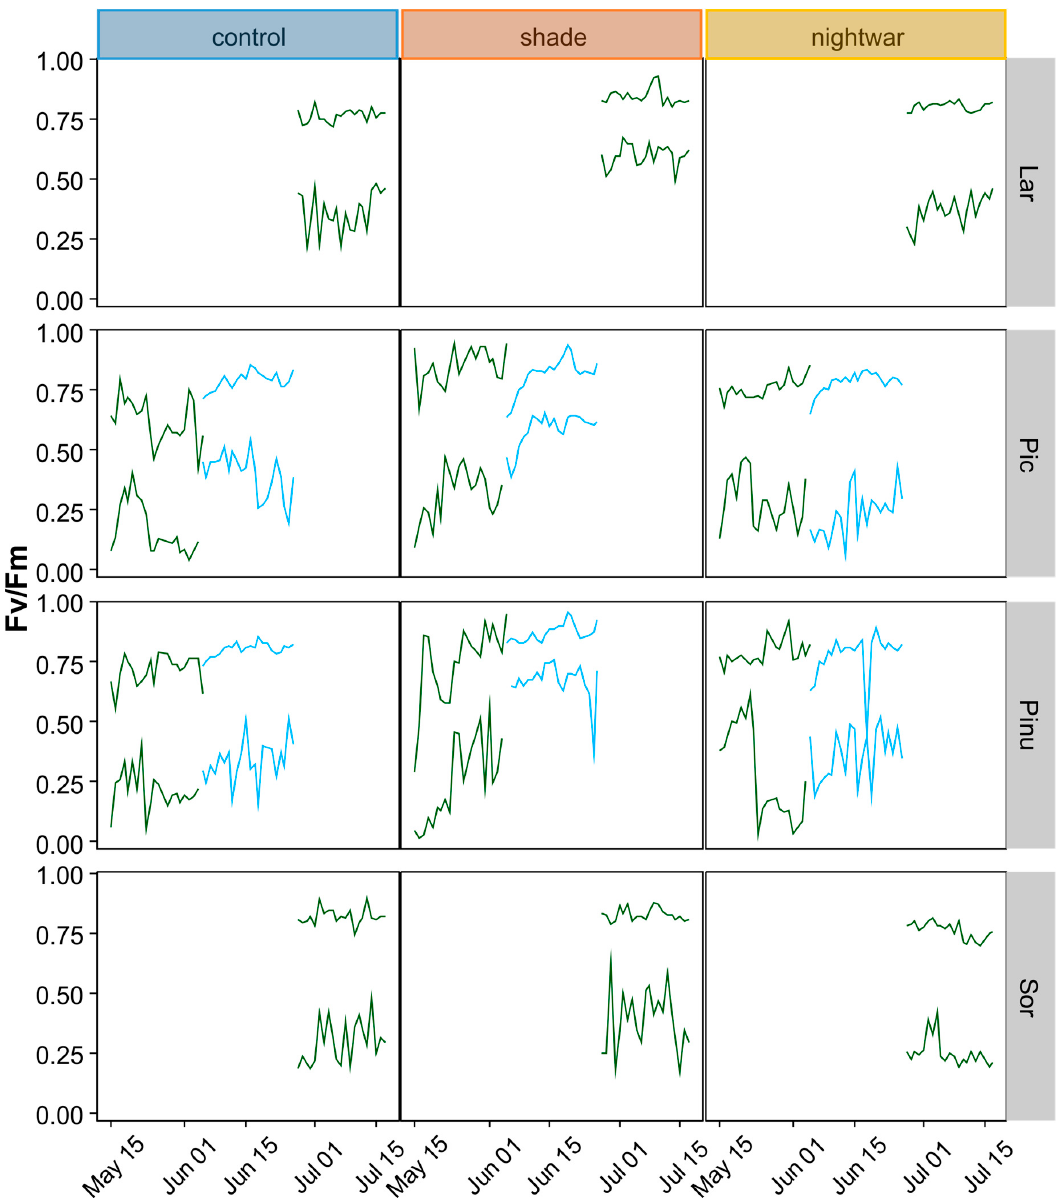
Figure A3. Time-courses of the quantum yield (chlorophyll fluorescence parameter Fv/Fm, or Δ F/Fm´ during daylight hours) in seedlings of four tree species grown in different experimental treatments near the treeline in the French Alps. Species: Lar = Larix decidua , Pic = Picea abies , Pinu = Pinus uncinata, Sor = Sorbus aucuparia . Line colors indicate the snow treatments: early (dark green) and late (blue). Columns correspond to sky-exposure treatments: control (no roof), shade (shade roof during the day), and nightwar = night warming (shade roof during the night). Shown are minimum and maximum daily values from measurements in two plots per treatment (i.e., in two blocks). Maximum values correspond to pre-dawn values and are taken to indicate stress when below ca. 0.7.